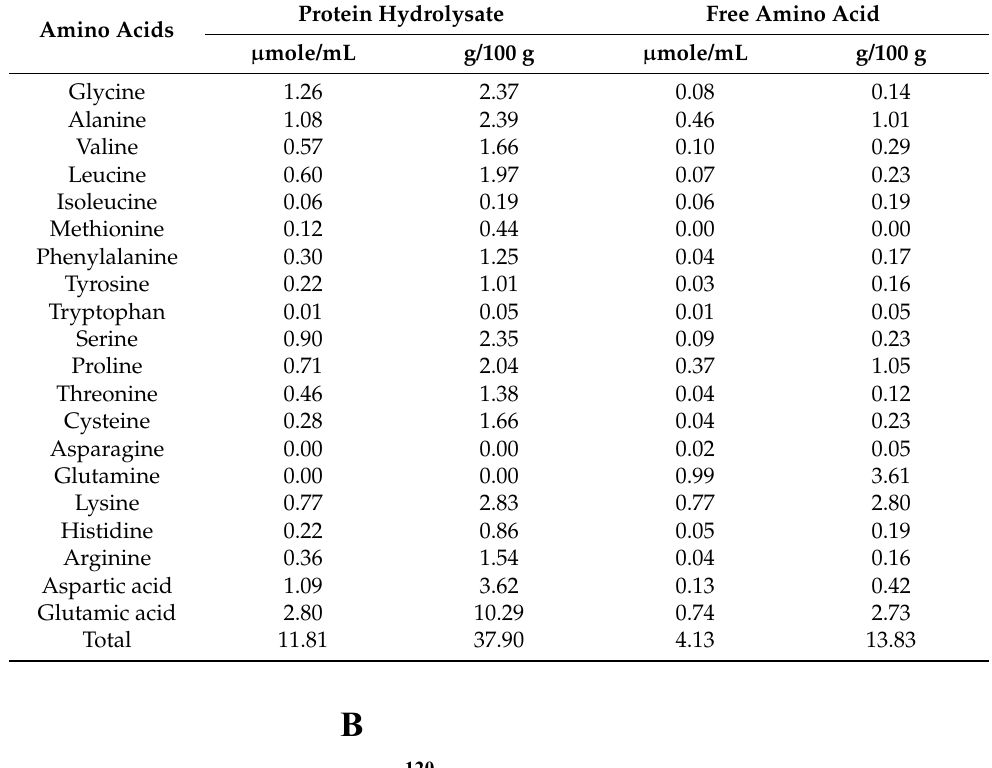
Table 2. Amino acid compositions of S. pastorianus extract.